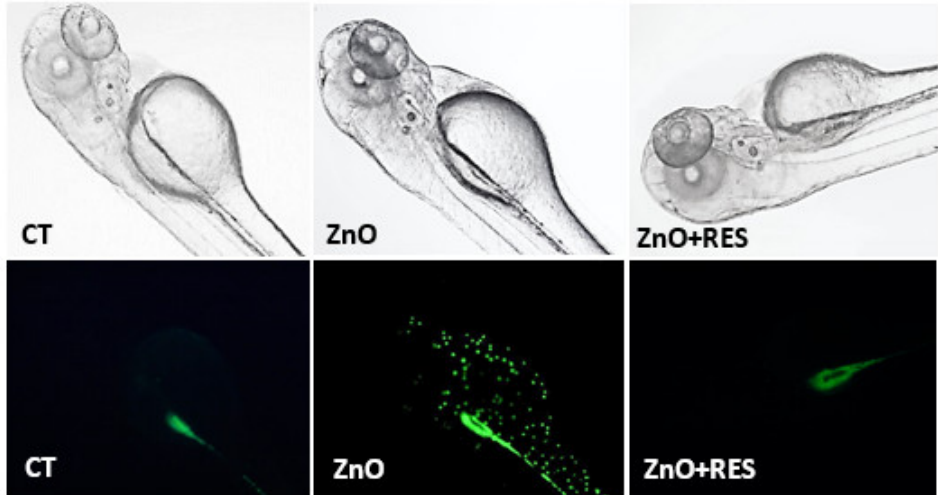
Figure 3. Resveratrol counteracts ZnO NP-induced ROS production in zebrafish embryos. Qualitative localization analysis in 72-hpf zebrafish embryos after staining with 5 μM Carboxy-H2DCFDA probe. (CT) localization of ROS production in untreated zebrafish embryos. (ZnO) localization ROS production in embryos exposed to 3 mg/L ZnO NP. (ZnO + RES) localization ROS production in embryos exposed to 3 mg/L ZnO NP + 5 μM resveratrol. RES, resveratrol. Magnification 10×.